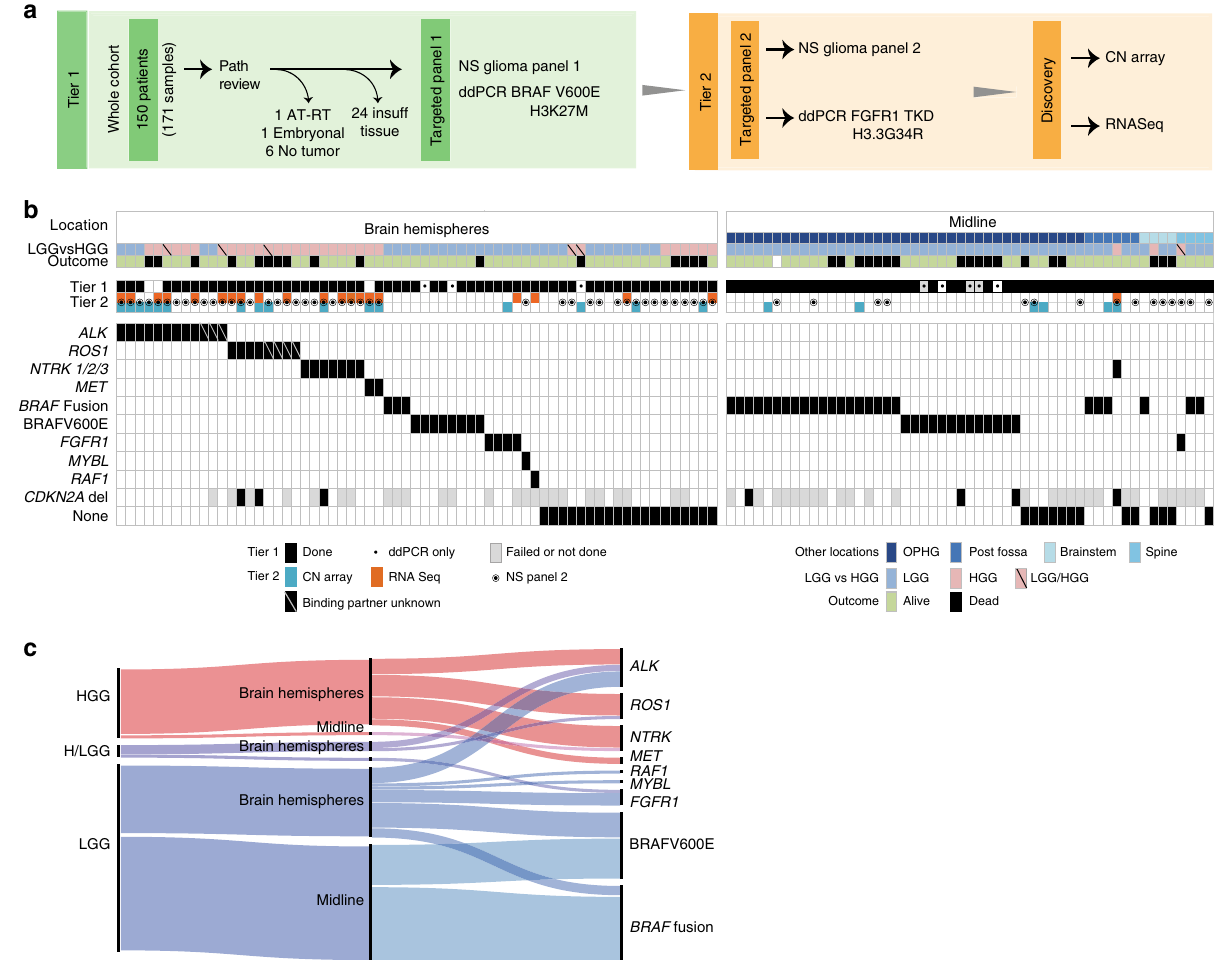
Fig. 1 Molecular characteristics of infant gliomas. a The testing strategy used to identify the molecular driver of the tumor. Samples testing positive in tier 1 did not proceed to tier 2. b Clinical and genomic features of the infant glioma cohort highlighting the molecular alterations and clinical features associated with them including tumor location, grade and outcome. c Alluvial plot (https://rawgraphs.io/) showing the distribution of molecular drivers according to tumor location and histology. Red: high-grade glioma, Purple: mixed high and low-grade glioma, Blue: low-grade glioma. AT/RT: Atypical Teratoid Rhabdoid Tumors, NS: NanoString, CN: copy number, ddPCR: droplet digital PCR, HGG: high-grade glioma, LGG: low-grade glioma, OPHG: optic